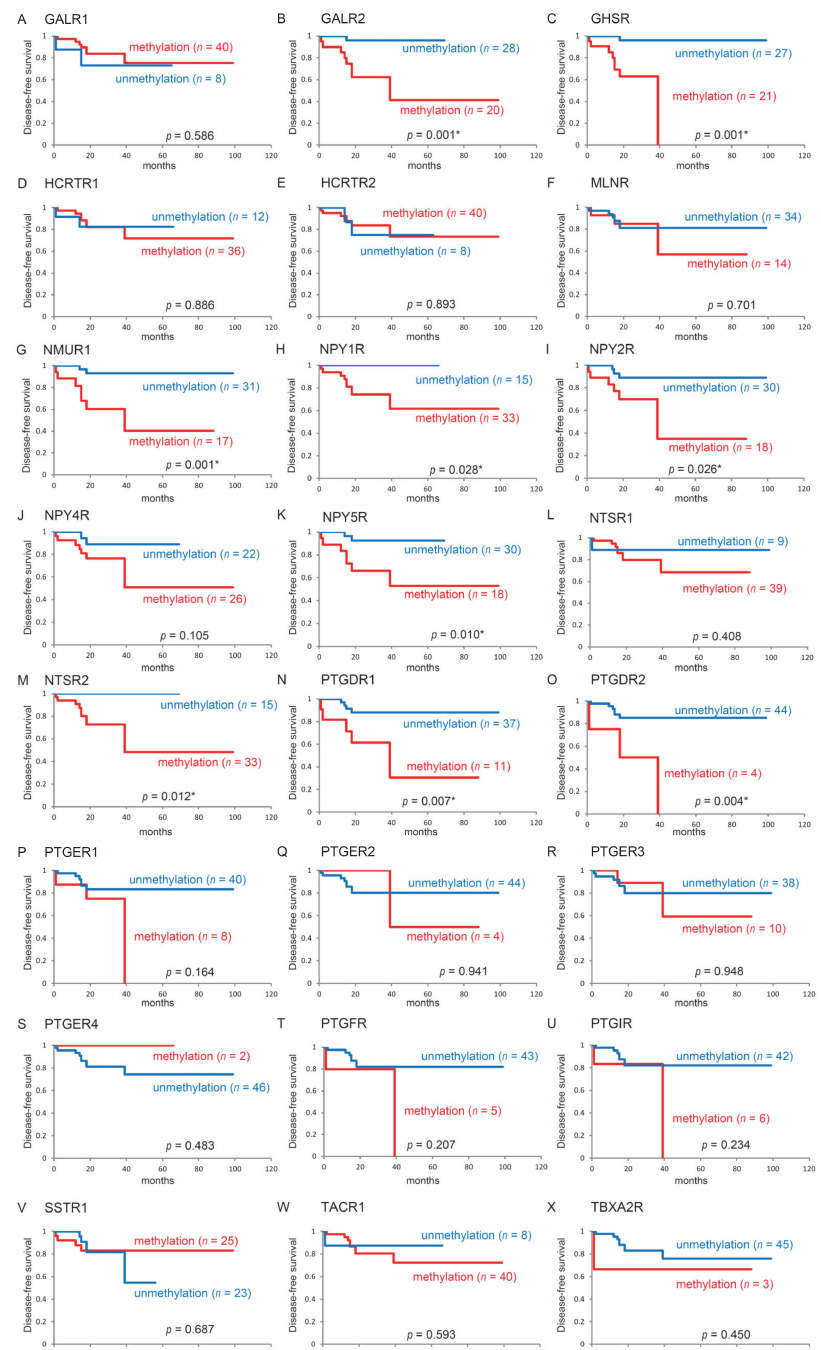
Figure 4. Kaplan–Meier survival curves for 48 patients with HPV-associated oropharyngeal cancer according to the methylation statuses of 24 target genes disease free survival (DFS) for ( A ) GALR1 , ( B ) GALR2 , ( C ) GHSR , ( D ) HCRTR1 , ( E ) HCRTR2 , ( F ) MLNR , ( G ) NMUR1 , ( H ) NPY1R , ( I ) NPY2R , ( J ) NPY4R , ( K ) NPY5R , ( L ) NTSR1 , ( M ) NTSR2 , ( N ) PTGDR1 , ( O ) PTGDR2 , ( P ) PTGER1 , ( Q ) PTGER2 , ( R ) PTGER3 , ( S ) PTGER4 , ( T ) PTGFR , ( U ) PTGIR , ( V ) SSTR1 , ( W ) TACR1 , and ( X ) TBXA2 R for methylated (red lines) and unmethylated (blue lines) genes. A value of p < 0.05 has been considered statistically